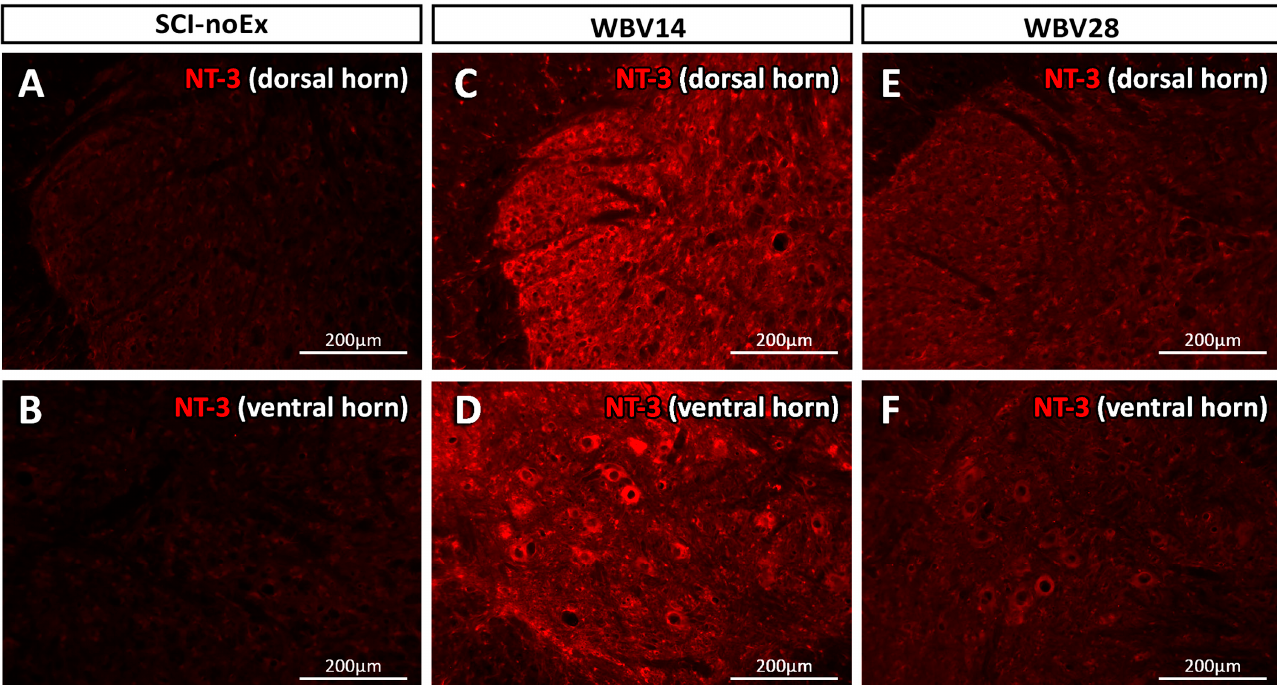
Figure 7. Immunostaining of NT-3 in a transverse section of the lumbar spinal cord L2 segment, using rabbit anti-NT-3 and sheep anti-rabbit Cy3 conjugated IgG antibodies at 12 weeks after SCI NT-3 immunostaining was evident throughout the gray matter, in both ventral horn ( B , D , F ) and dorsal horn ( A , C , E ). The NT-3 was highly expressed in α -motoneurons of the ventral horn at WBV14, where we observed clinical recovery. Small cells, presumably interneurons or glial cells, also showed NT-3-positivity. ( A , B ) SCI-noEx, ( C , D ) WBV14, ( E , F )